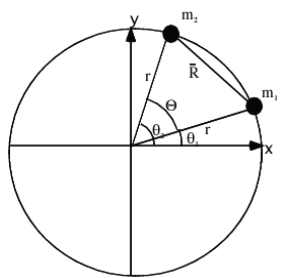
Figure 6. Illustration of two particles moving on a